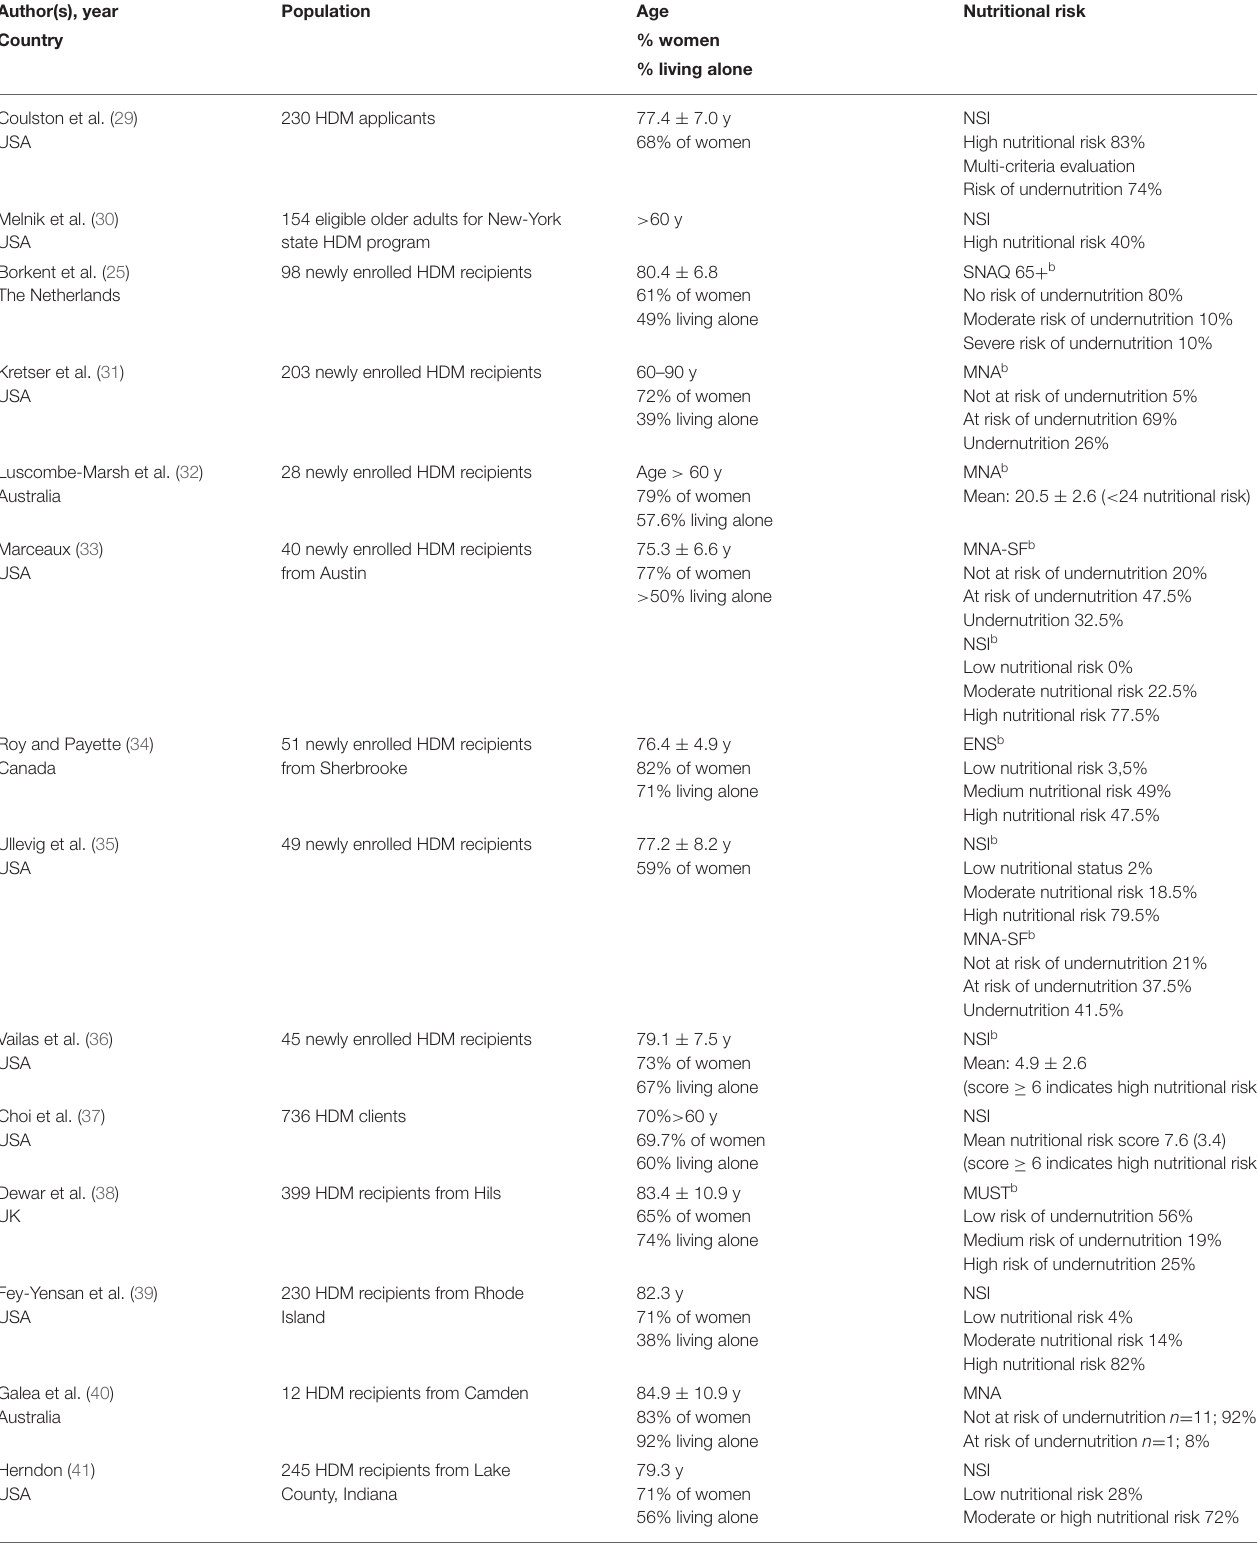
TABLE 2 | Characterization of nutritional risk in HDM applicants and